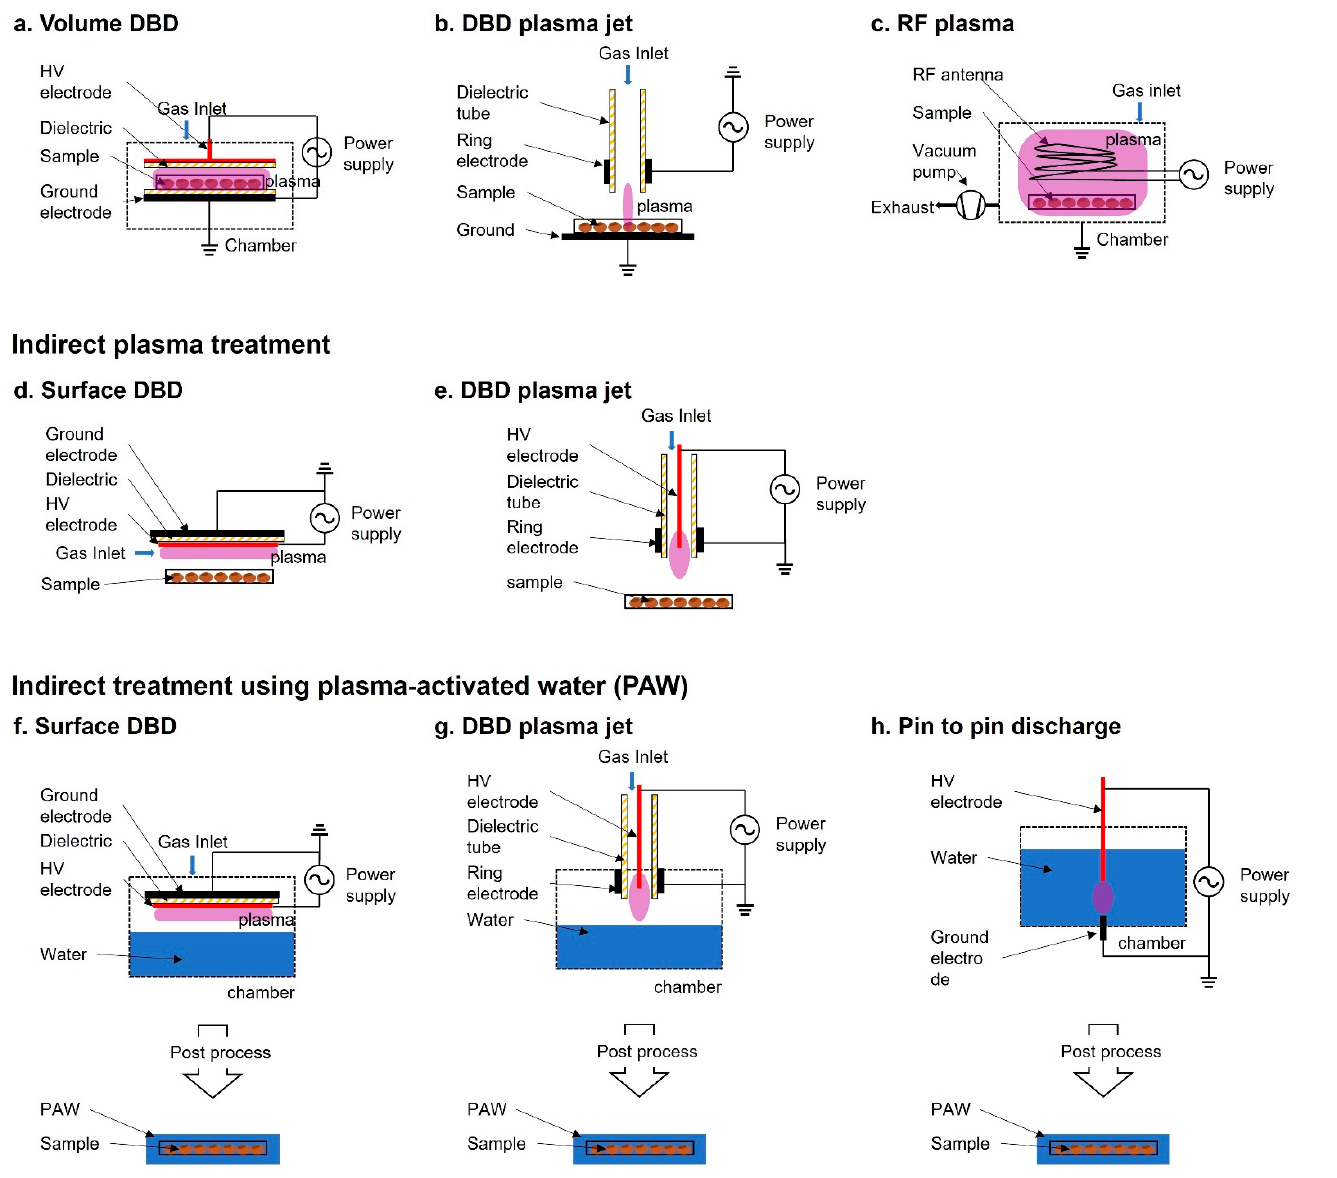
Figure 1. Schematic diagram of plasma devices used for seed treatment. ( a – c ) Direct plasma treatment: ( a ) volume dielectric barrier discharge (DBD), ( b ) DBD plasma jet, ( c ) Radiofrequency (RF) plasma; ( d , e ) Indirect plasma treatment where the sample is not directly in contact with the plasma discharge: ( d ) surface DBD, ( e ) DBD plasma jet; ( f – h ) Indirect treatment using plasma-activated water (PAW), ( f ) surface DBD, ( g ) DBD plasma jet, ( h ) pin-to-pin discharge.